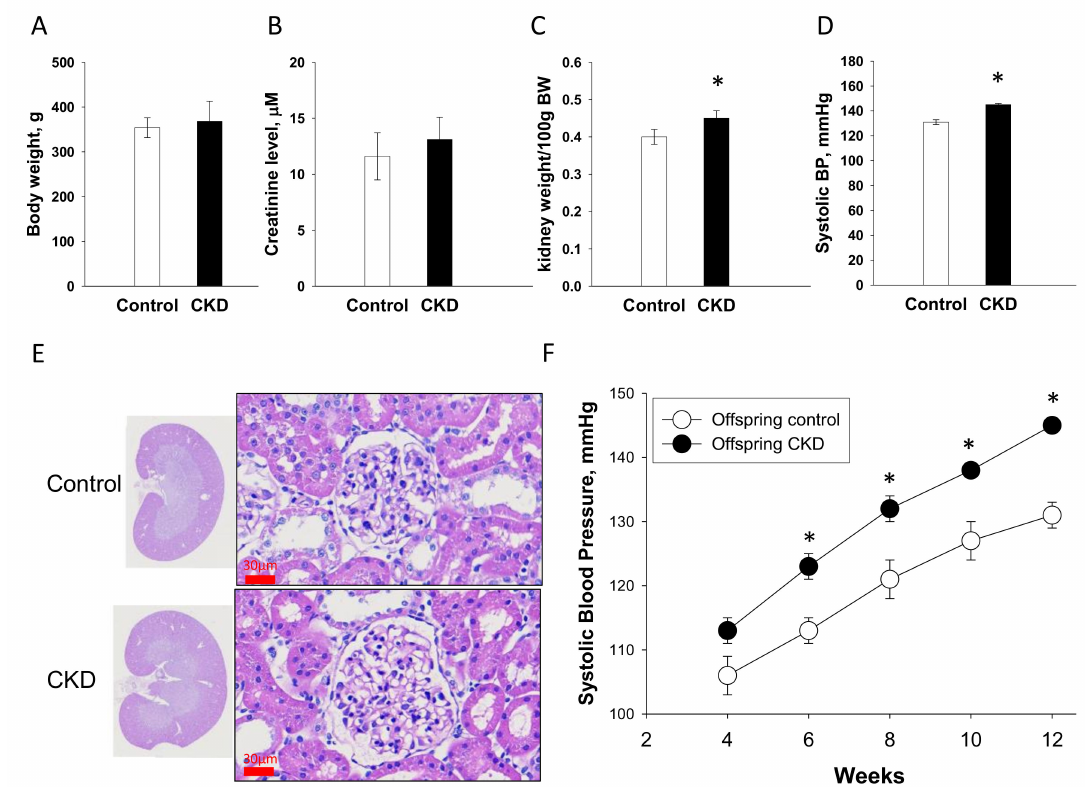
Figure 5. Renal outcome measures in male o ff spring rats. ( A ) Body weights, ( B ) plasma creatinine level, ( C ) kidney weight-to-body weight ratio, ( D ) systolic blood pressures, and ( E ) periodic acid-Schi ff stained sections demonstrating renal histopathology of male o ff spring rats at 12 weeks of age; scale bar = 30 µ m, ( F ) systolic blood pressure in male o ff spring from 4 to 12 weeks of age. Control = male o ff spring born to dams fed with regular chow; CKD = male o ff spring born to dams received chow supplemented with 0.5% adenine for 3 weeks before pregnancy. Data are shown as means ± SD; n = 8 / group. The asterisk indicates p < 0.05 vs.